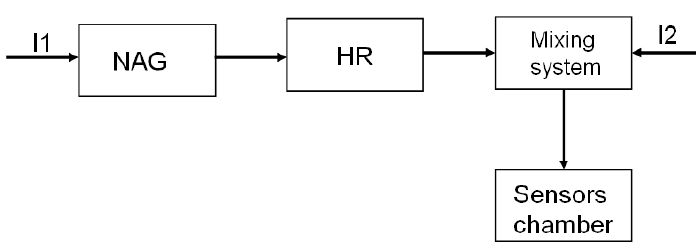
Figure 3. Scheme of the EOS 507